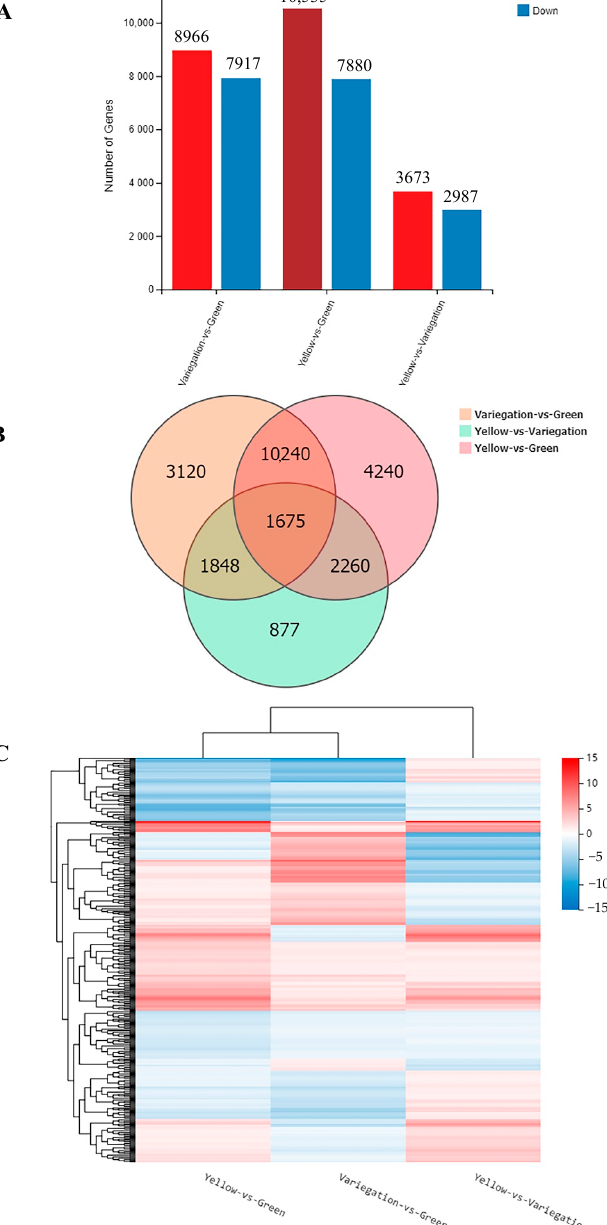
Figure 7. Statistical and clustering analysis of differentially expressed genes. ( A ) Statistic of differen- tially expressed genes. Upregulated genes were shown in red and downregulated genes were shown in blue. ( B ) Venn diagram of differentially expressed genes. Numbers in the overlapping regions indicate genes differentially expressed in more than one pairwise comparison. ( C ) Clustering heat map of differentially expressed genes. Red color in the figure represents the highly expressed genes and blue color represents the genes expressed at low